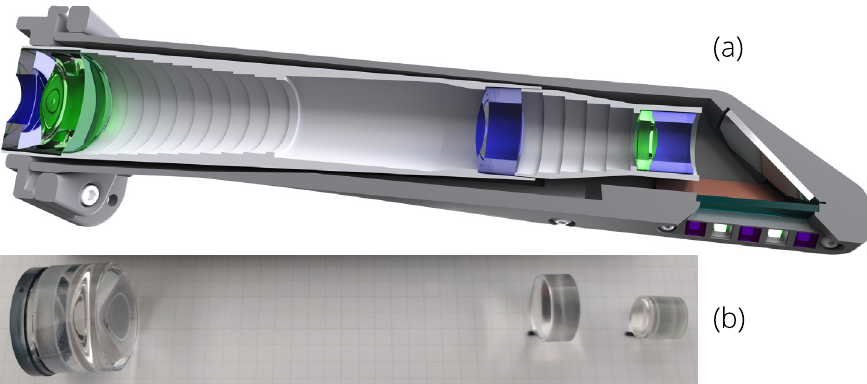
Fig 2. (a) Intraoral probe section view showing the mechanical structure, lenses, and illumination LEDs; and (b) the diamond turned